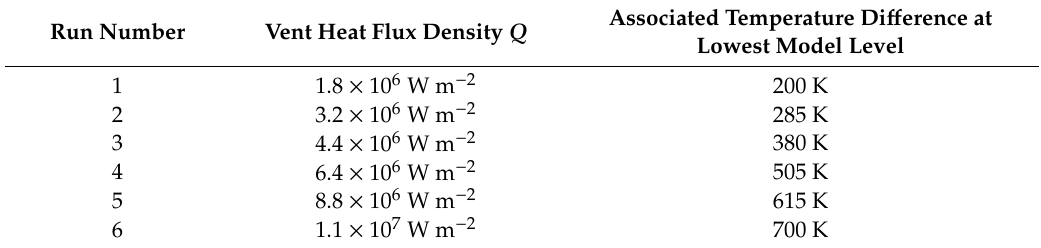
Table 1. Selected Values of Temperature, Surface Heat Flux and Perturbation Temperature for Figure 1.